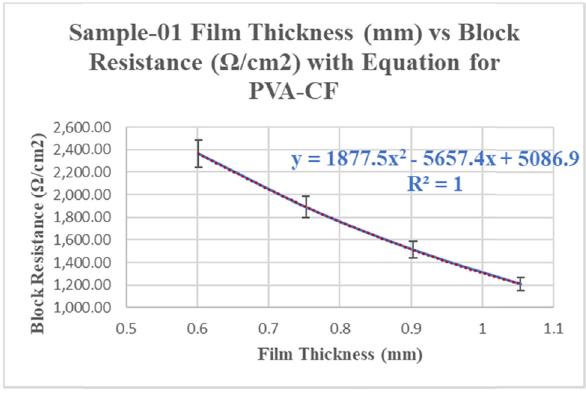
Figure 14: Sample - 04 ( CF:PVA = 0.6:30 ) block resistance ( Ω ) versus thickness ( mm ) with equation for PVA - CF. The dotted lines represent the polynomial fi tted curve and the linear fi tted